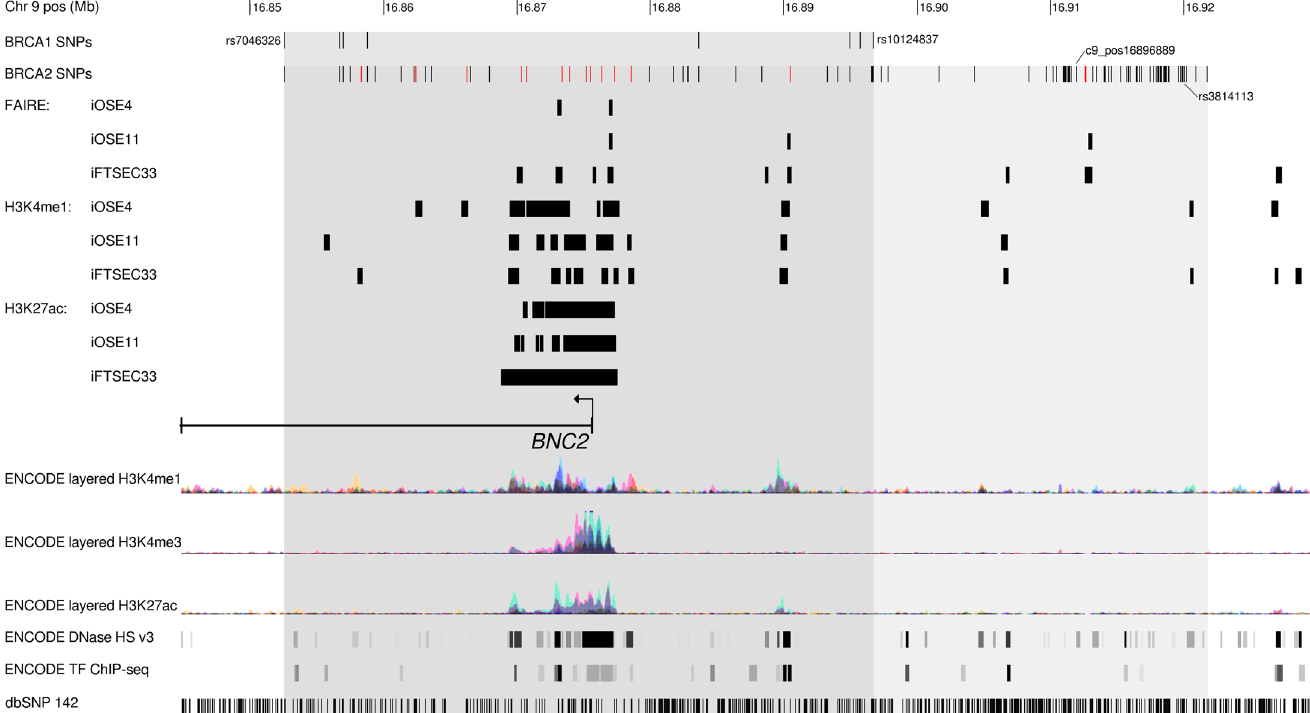
Fig 3. Genomic features surrounding the 9p22.2 locus. Illustration of the genomic region (chr9:16,839,835 – 16,924,468) encompassing peaks (shaded areas) containing candidate causal variants associated with ovarian cancer risk in BRCA1 and BRCA2 mutation carriers. Epigenomic data from Coetzee et al., (2015) [20] representing potential regulatory elements in ovarian cells (iOSE4 and iOSE11) and fallopian tube (FTSEC33) cells derived from formaldehyde assisted identification of regulatory elements sequencing (FAIRE-seq) and histone modification ChIP-seq are shown as black bars. Variants which overlap one of these features are coloured red. Data from the ENCODE project including histone modification ChIP-seq for three modifications (H3K4me1, H3K4me3, and H3K27ac) are shown as coloured histograms, as well as DNaseI hypersensitive site mapping and transcription factor ChIP-seq. The positions of all common SNPs from dbSNP build 142 are shown in the lowest track.